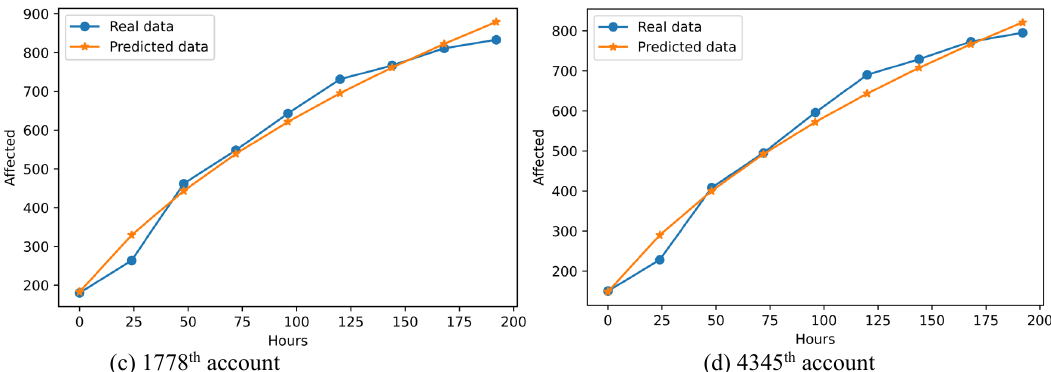
Fig. 5. Comparison between real and predicted number of affected data from four randomly selected users Fig. 5. shows a comparison between the real data and the estimated number of other users affected during the training